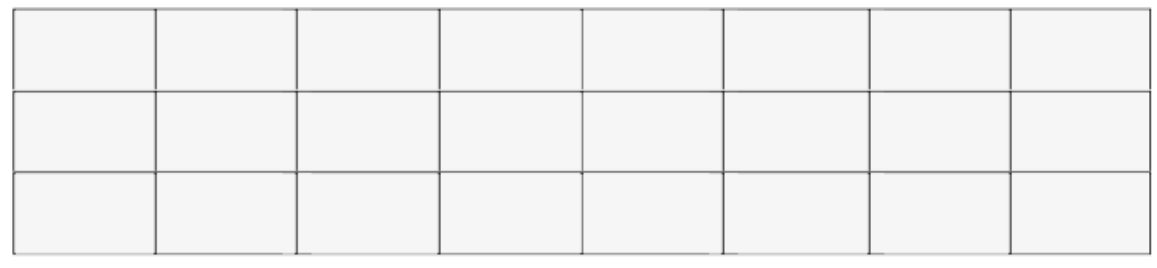
Figure 2. Cellular field in three stripes